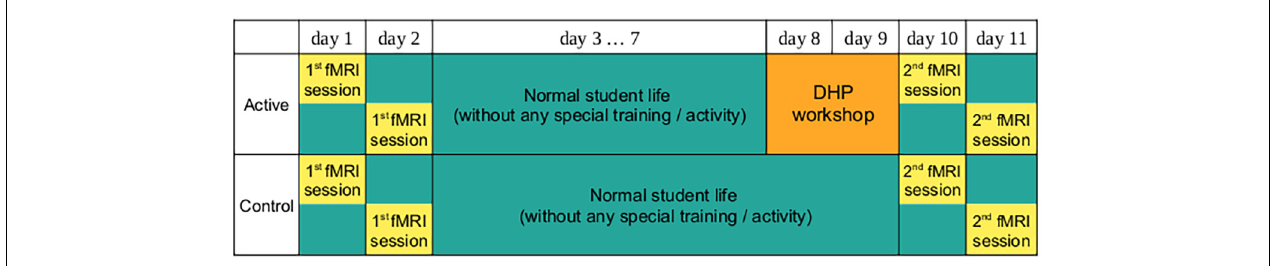
FIGURE 1 | Flow Chart of the Study. All subjects had a same-length interval (8 days) between the first and second MRI measurements. The second examination of the active group was performed within 2 days after the DHP